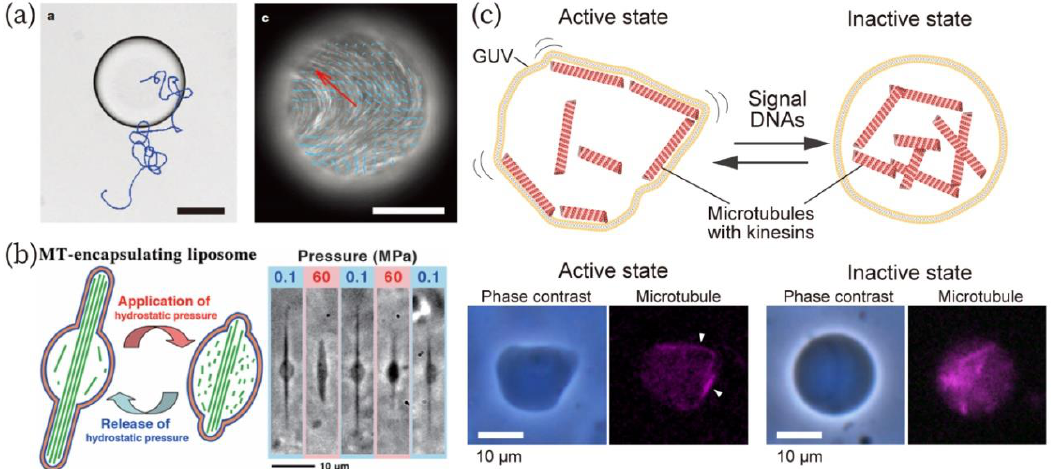
Figure 6. ( a ) Autonomous motility of the W / O droplet containing microtubule-kinesin bundles [120]. A bright-field image of the droplet (left) and a fluorescence image of microtubules (right). Scale bars: 80 µ m (left) and 100 µ m (right). Reproduced with permission from [120]. ( b ) Morphological changes of GUVs encapsulating tubulins that are polymerized to microtubules in response to hydrostatic pressures [14]. Reproduced with permission from [14]. ( c ) An amoeba-type molecular robot capable of changing its shape in response to signal DNA molecules [127]. Reproduced with permission from [127].